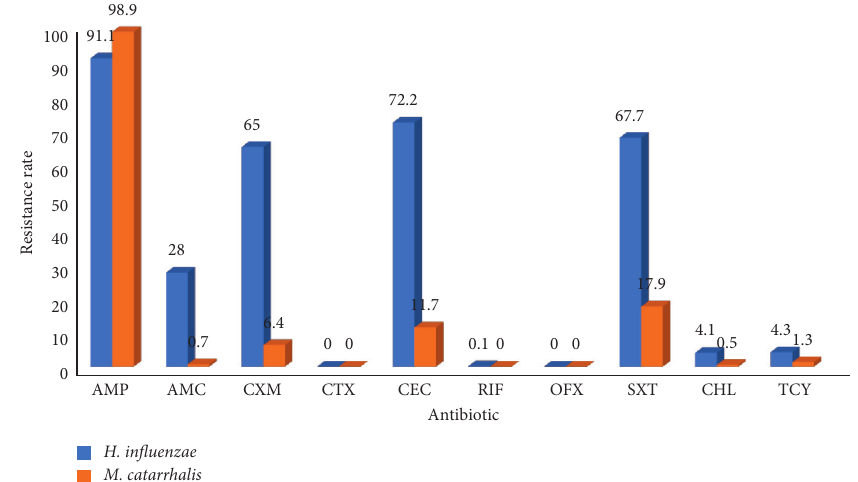
Figure 16: Distribution of drug resistance of H. influenzae and M. catarrhalis from 2018 to 2020 (%).